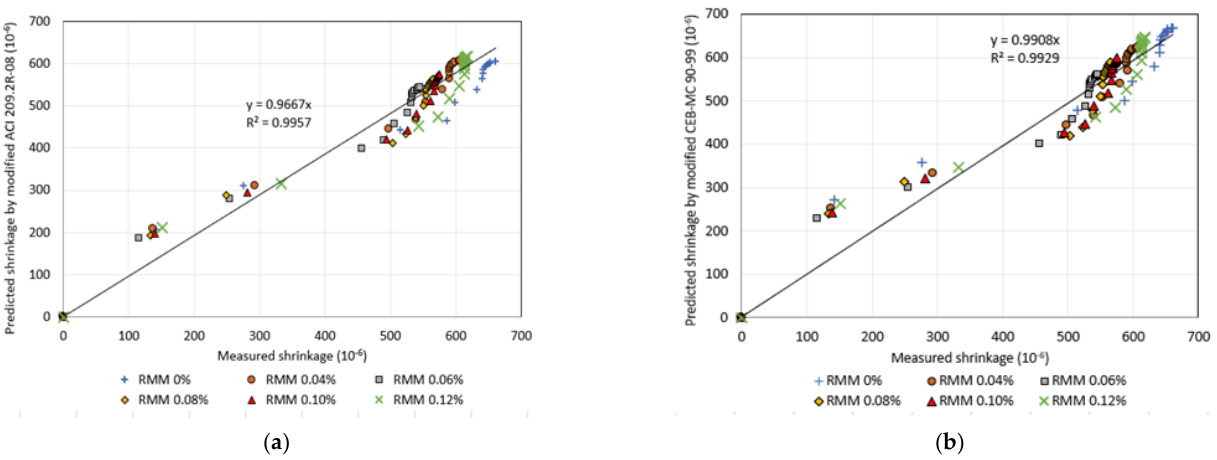
Figure 10. Evaluation of the modified ACI 209.2R-08 ( a ) and the modified CEB-MC 90-99 ( b ) models by best fit line method.